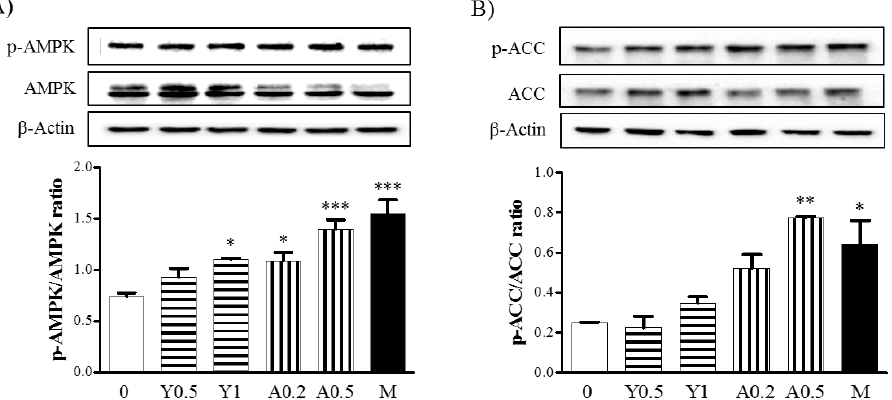
Figure 3. Effects of yam extract and allantoin on the phosphorylation of AMPK and ACC protein inC2C12 myotubes. Differentiated C2C12 myotubes were treated with or without yam extract